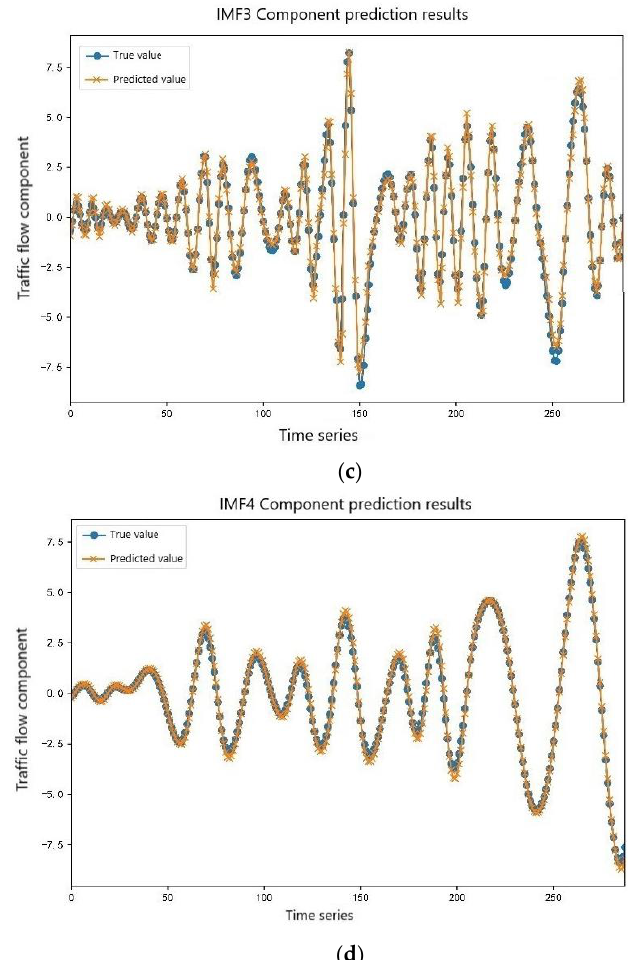
Figure 9. Prediction results of the high-frequency component sequences. ( a ) IMF1 component prediction results. ( b ) IMF2 component prediction results. ( c ) IMF3 component prediction results. ( d ) IMF4 component prediction results.